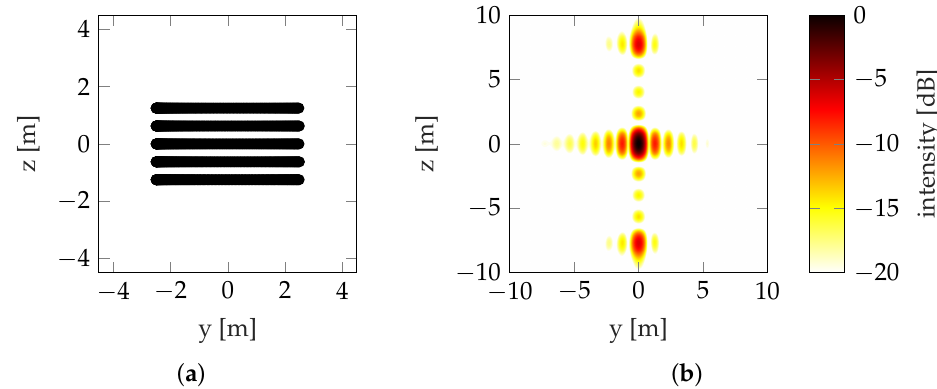
Figure 22. Reference scenario with five passes: ( a ) Trajectory. ( b )